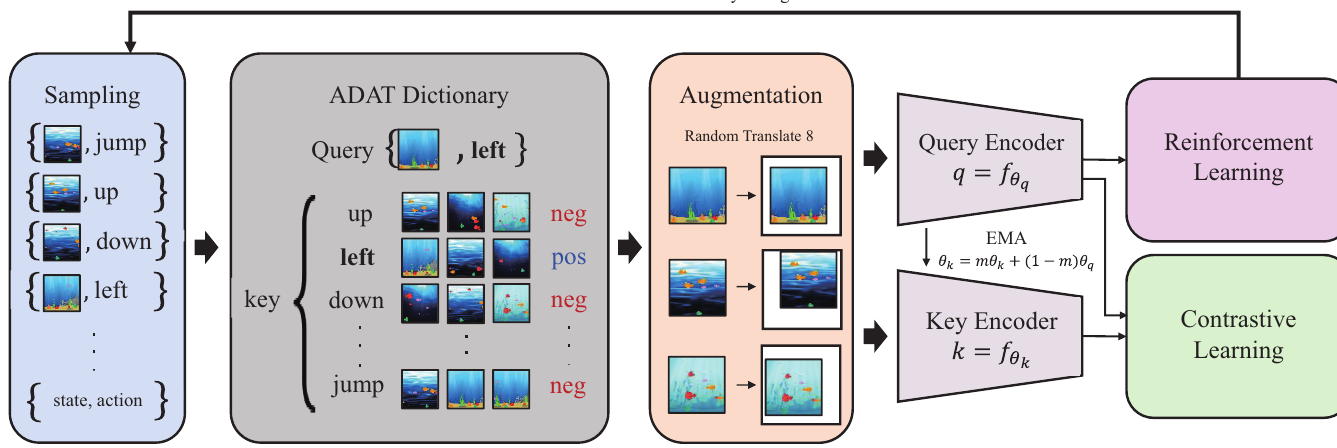
Fig 2. The overall framework of ADAT. State-action pairs are sampled from a history of interactions. The dictionary is built with states by action types, labeling keys based on the query’s action. Through augmentation ‘Random-Translate’ [22], query is encoded for reinforcement learning and query-key pairs are encoded for contrastive learning [20]. Only the query encoder learns from contrastive loss, and the key encoder is trained as Momentum Update